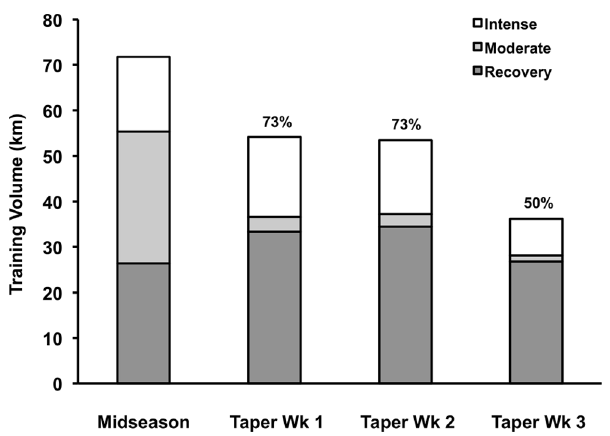
Figure 2. Summary of training volume and intensity during heavy training (11 wks) and each week of taper (3 wks), reproduced from Luden et al. [2] with permission from the American Physiological